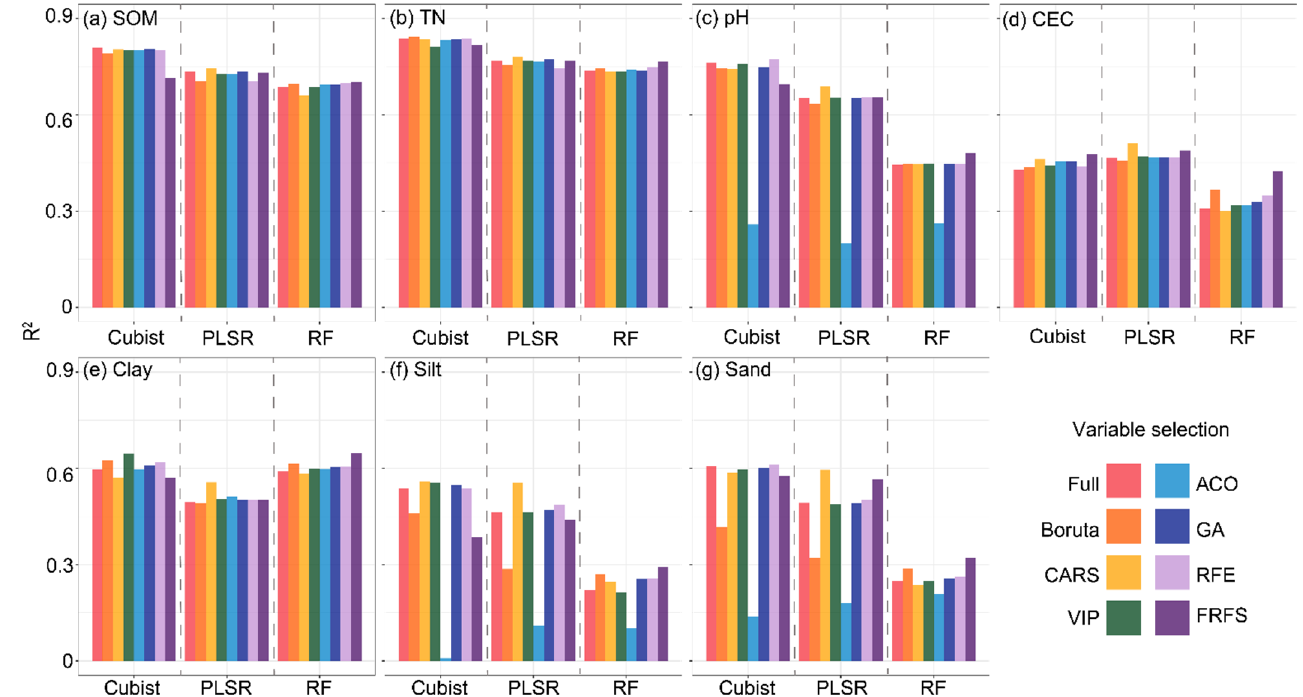
Figure 6. The model performance (R 2 ) of three predictive algorithms and seven variable selection algorithms. The full means the model built on the full spectra, which would be useful for model comparison.